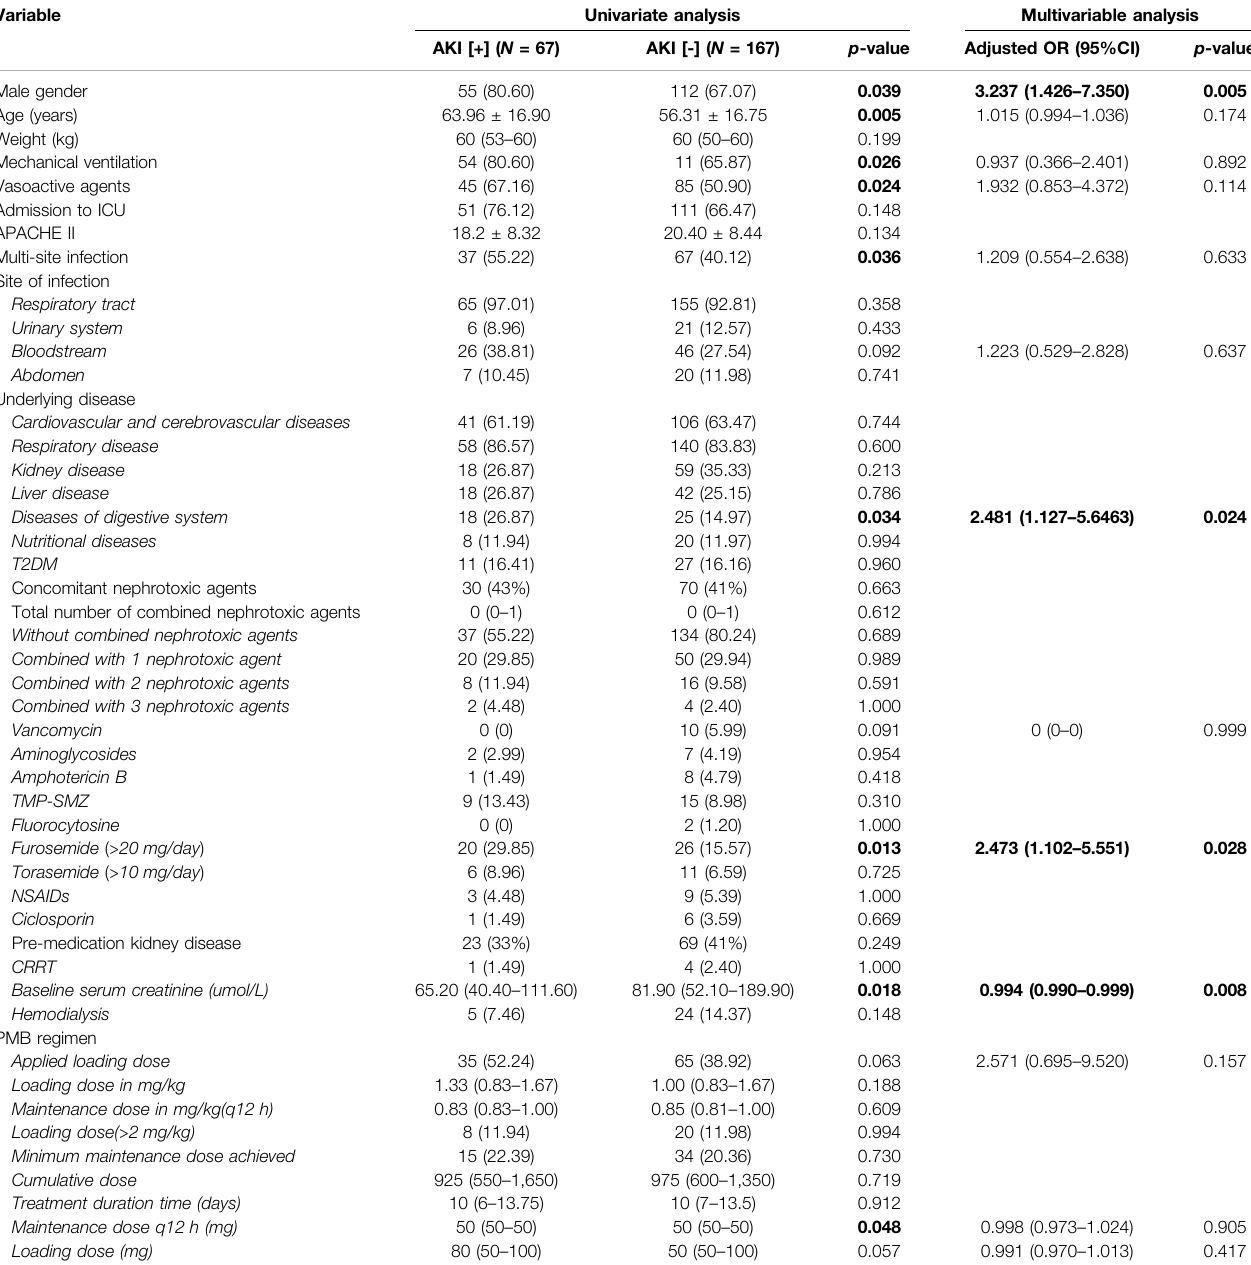
TABLE 2 | Univariate and multivariate analysis for the factors potentially associated with acute kidney injury in patients treated with PMB.